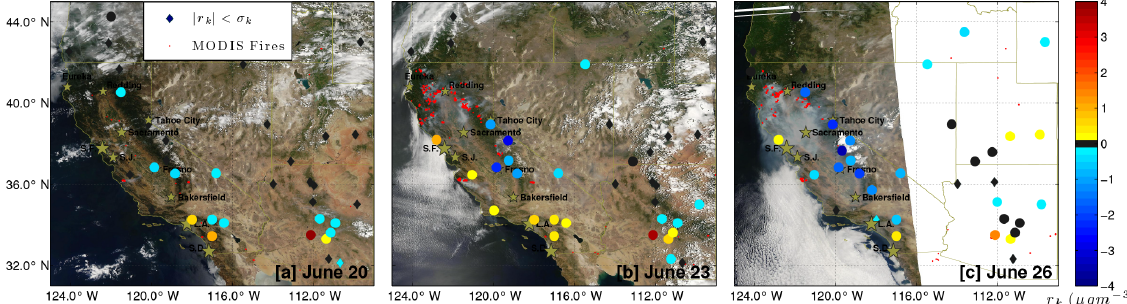
Figure 5. Surface site residual model error, r k , overlaid on MODIS Aqua true color images and active fire retrievals. Observations with a bias less than 1SD are also